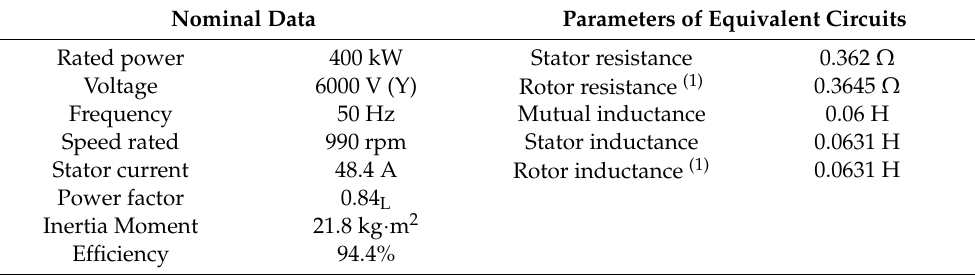
Table A1. Parameters of the type SF400X6 squirrel cage induction motor.